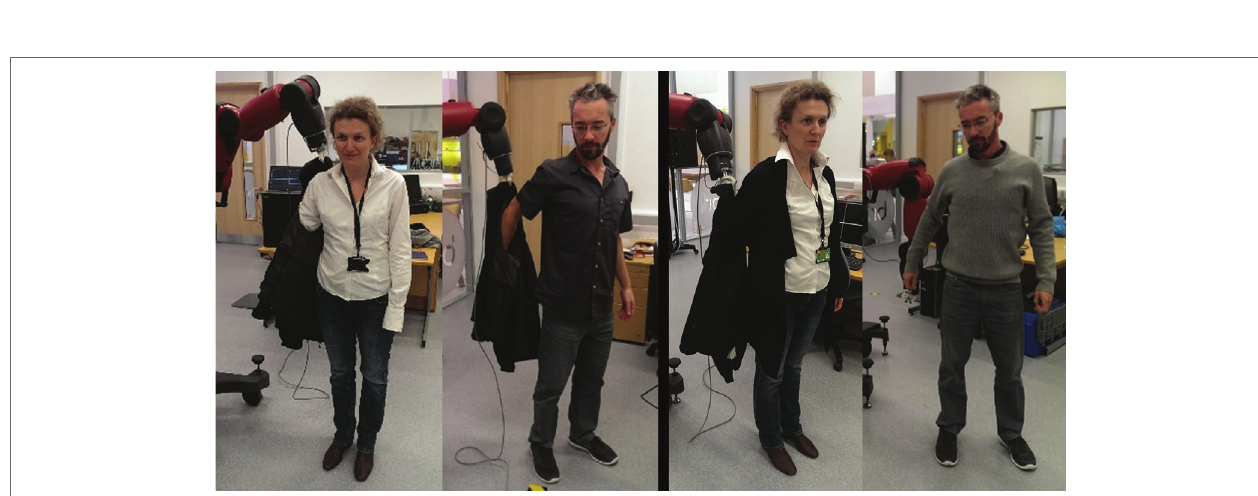
FigUre 4 | Dressing motion for each pose: pose 1 shown with the shirt, pose 2 shown for the bare mannequin, and pose 3 with the t-shirt (top to bottom)